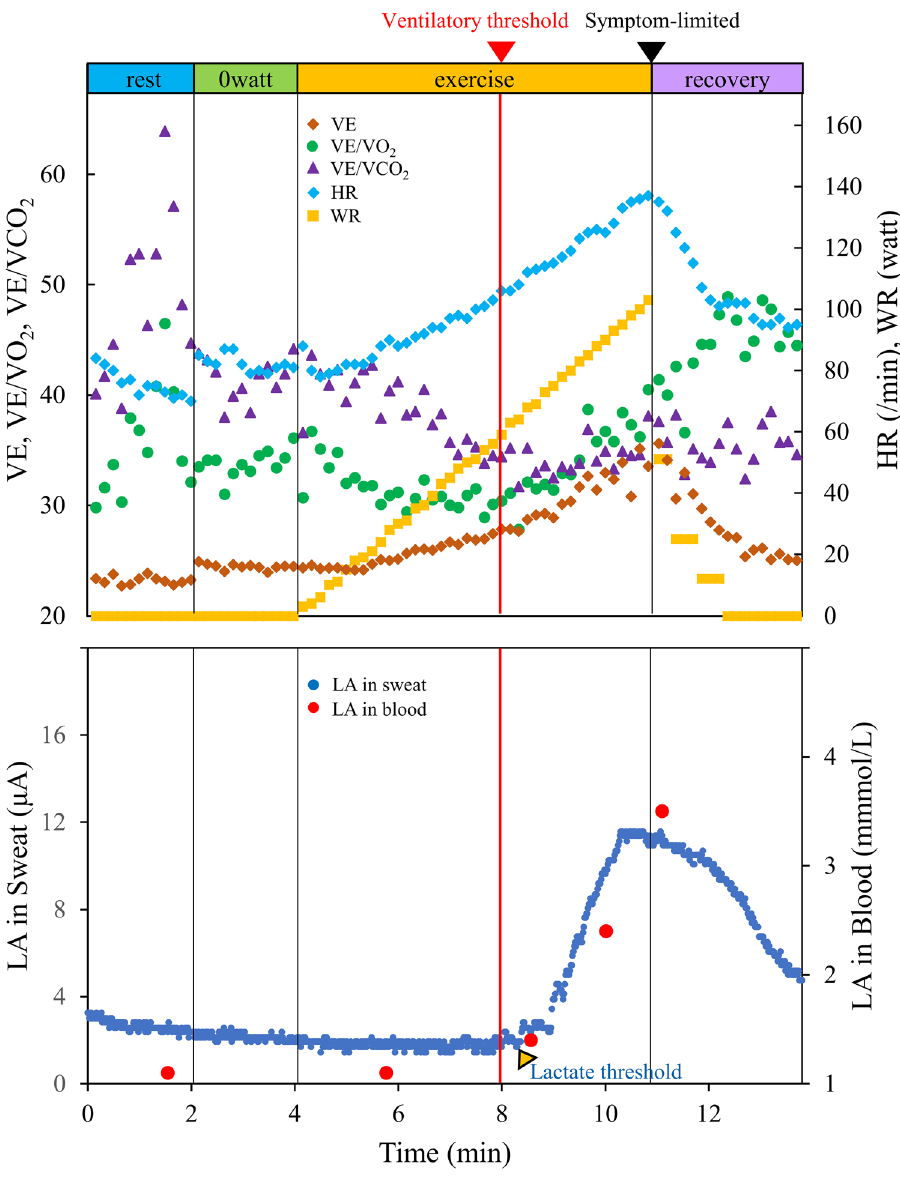
Figure 2. Imaging of the lactate in the sweat during incremental exercise. Representative graphs (dots) of the lactate in sweat (LA in sweat; dark blue) and lactate in blood (LA in blood; red) during exercise with a RAMP (15 W/min) protocol ergometer are shown in the lower panel. The respiratory gas data was shown in the upper panel. HR heart rate, LA lactate, VE ventilatory equivalent, VE/VCO 2 ventilation-carbon dioxide production, VE/VO 2 ventilation-oxygen uptake, WR work